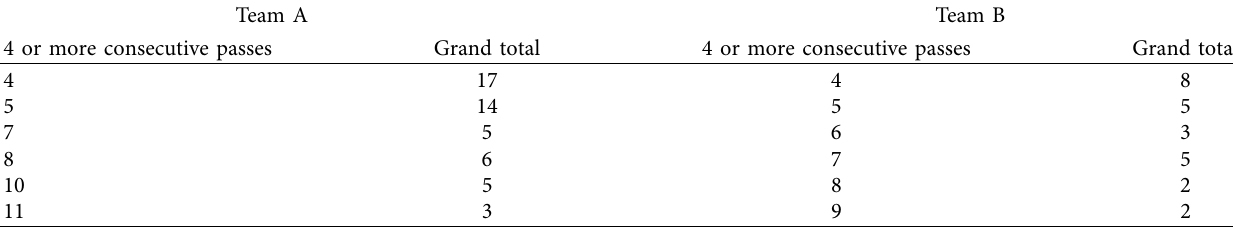
Table 4: Comparison of game statistics between team A and team B.